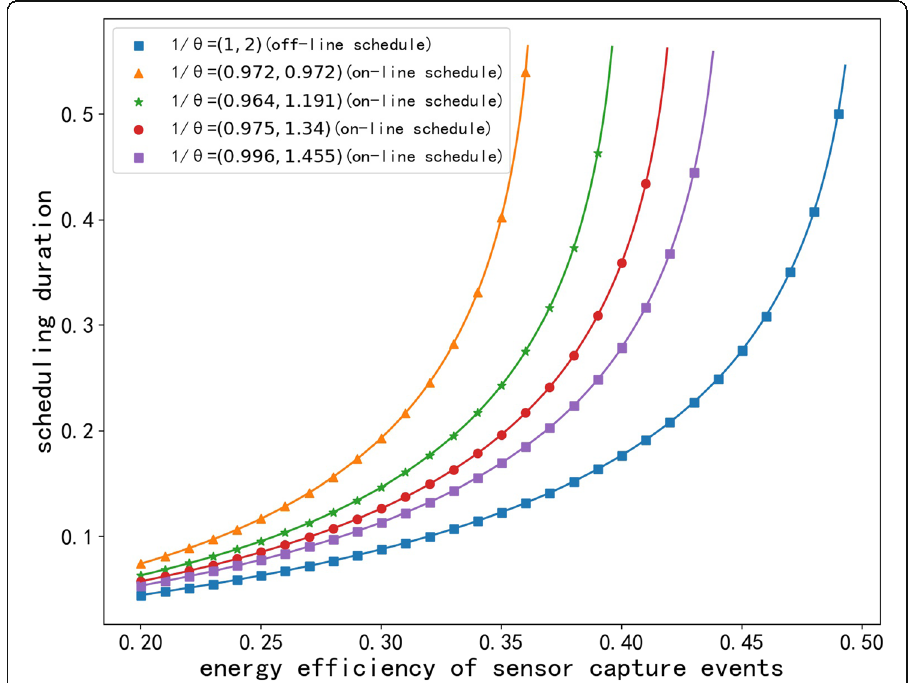
Fig. 4 Effect of energy efficiency of sensor captures events on scheduling duration in different scheduling